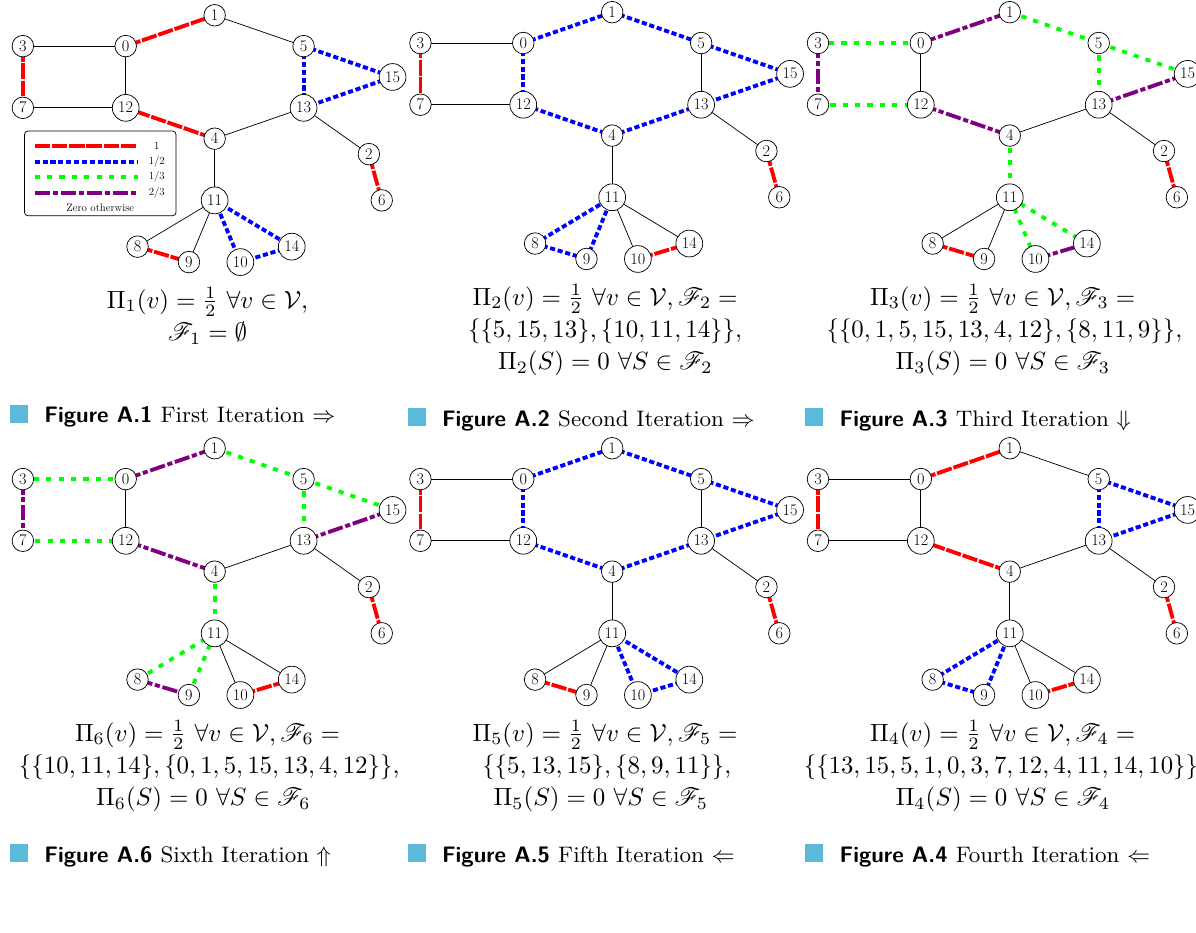
Figure A.1 First Iteration ⇒ Figure A.2 Second Iteration ⇒ Figure A.3 Third Iteration ⇓